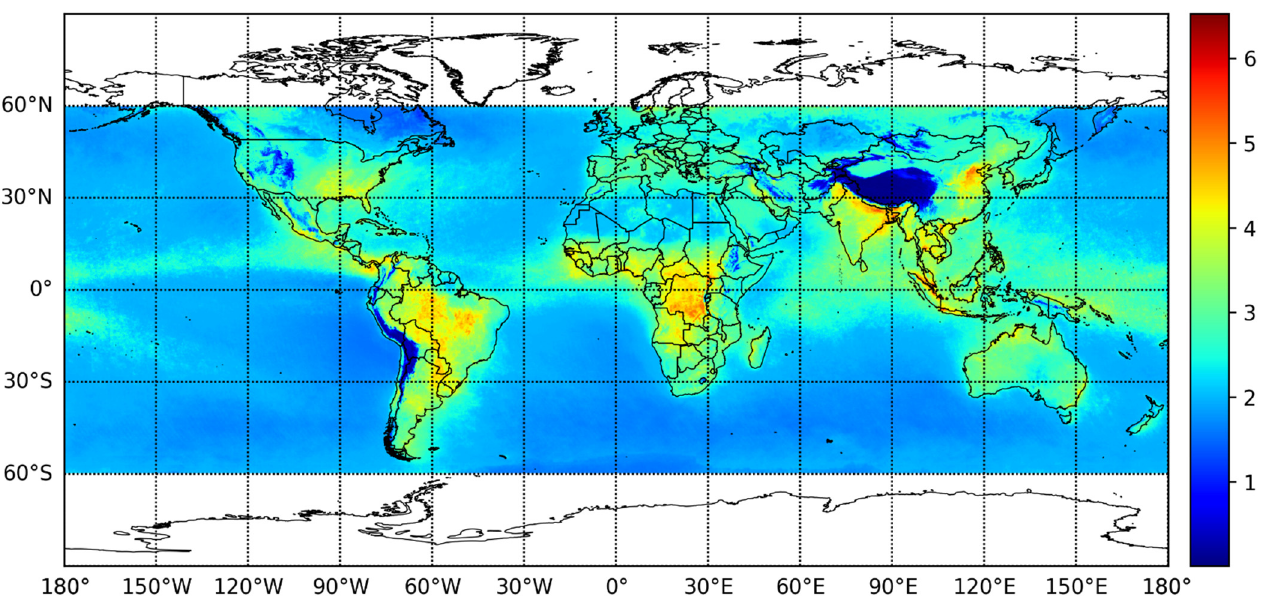
Table 1. MAE and RMSE of point estimation for surface concentration (unit: μ g/m 3 ). Dataset.